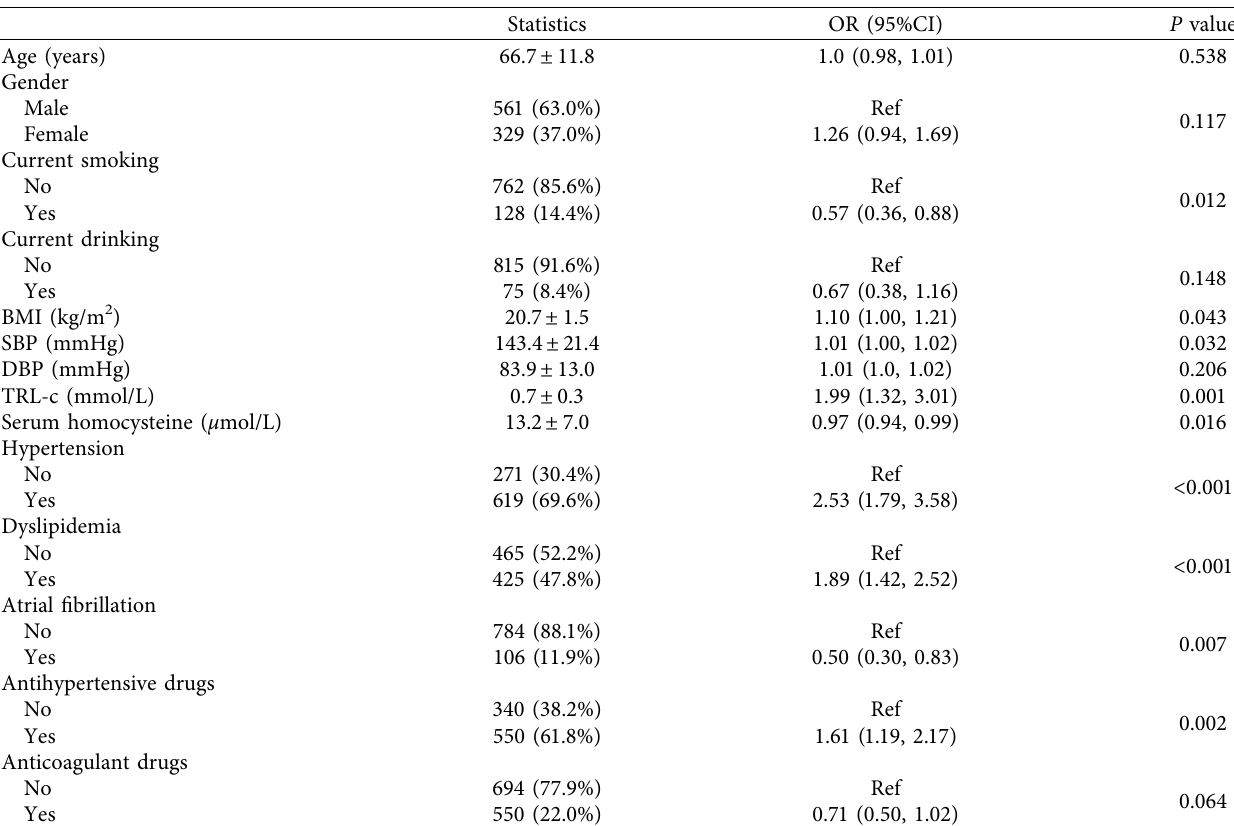
Table 2: Crude association of DM with common risk factors analyzed by univariate